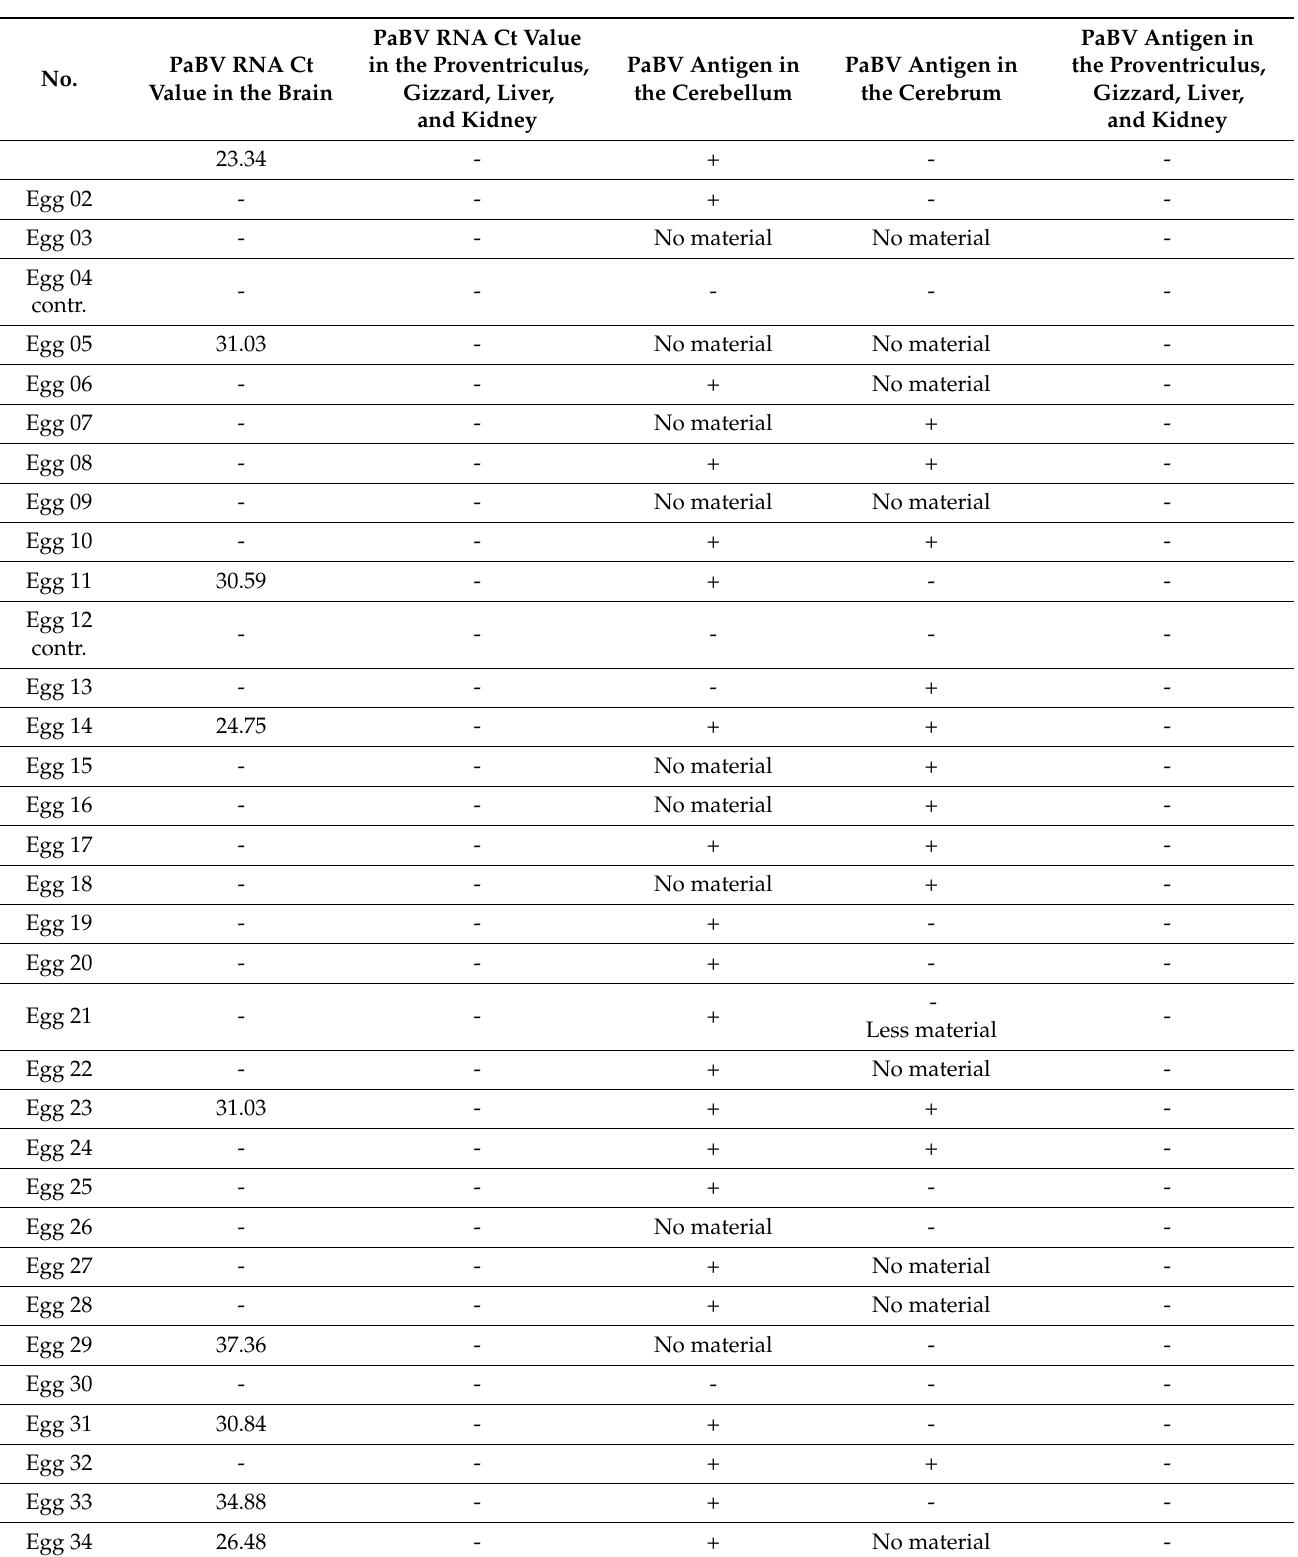
Table 1. Overview of the trial A results (yolk sac inoculation with parrot bornavirus 4